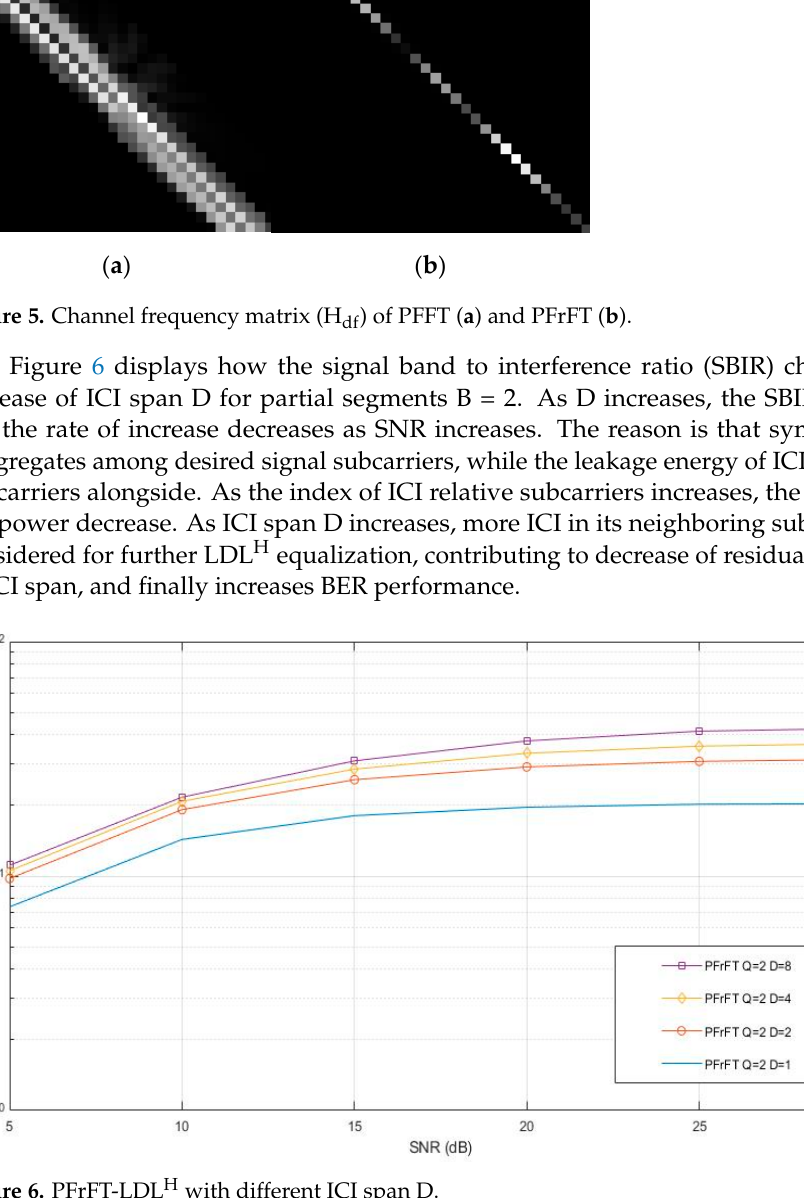
Figure 6. PFrFT-LDL H with different ICI span Figure 6. PFrFT ‐ LDL (cid:2892) with different ICI span D.